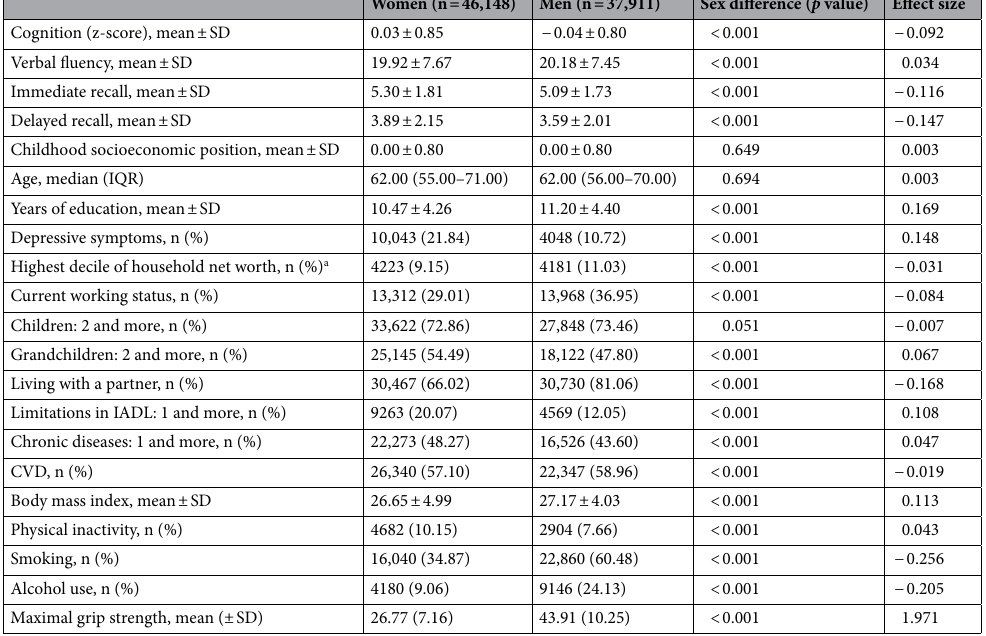
Table 1. Sex differences in baseline characteristics. a Binary variable instead of continuous was used for household ratio for comprehensive interpretation of the results. SD standard deviation, IQR interquartile range, IADL instrumental activities of daily living, CVD cardiovascular disease. Depressive symptoms are defined by 4 and more points on EURO-D scale. Alcohol use is defined as drinking more than 2 glasses of alcohol almost every day. Effect sizes are presented in Cramer’s V when Chi-square tests are employed on binary variables and in Cohen’s d when t-test have been used to compare continuous variables across